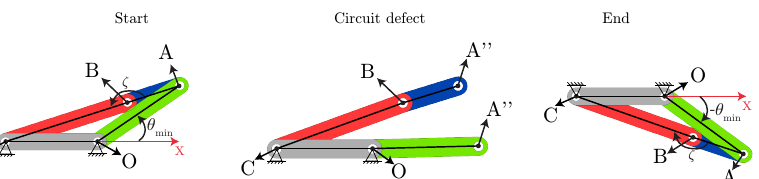
Figure 11. A designed linkage system that moves from one circuit to another must be disassembled, which is a circuit defect.